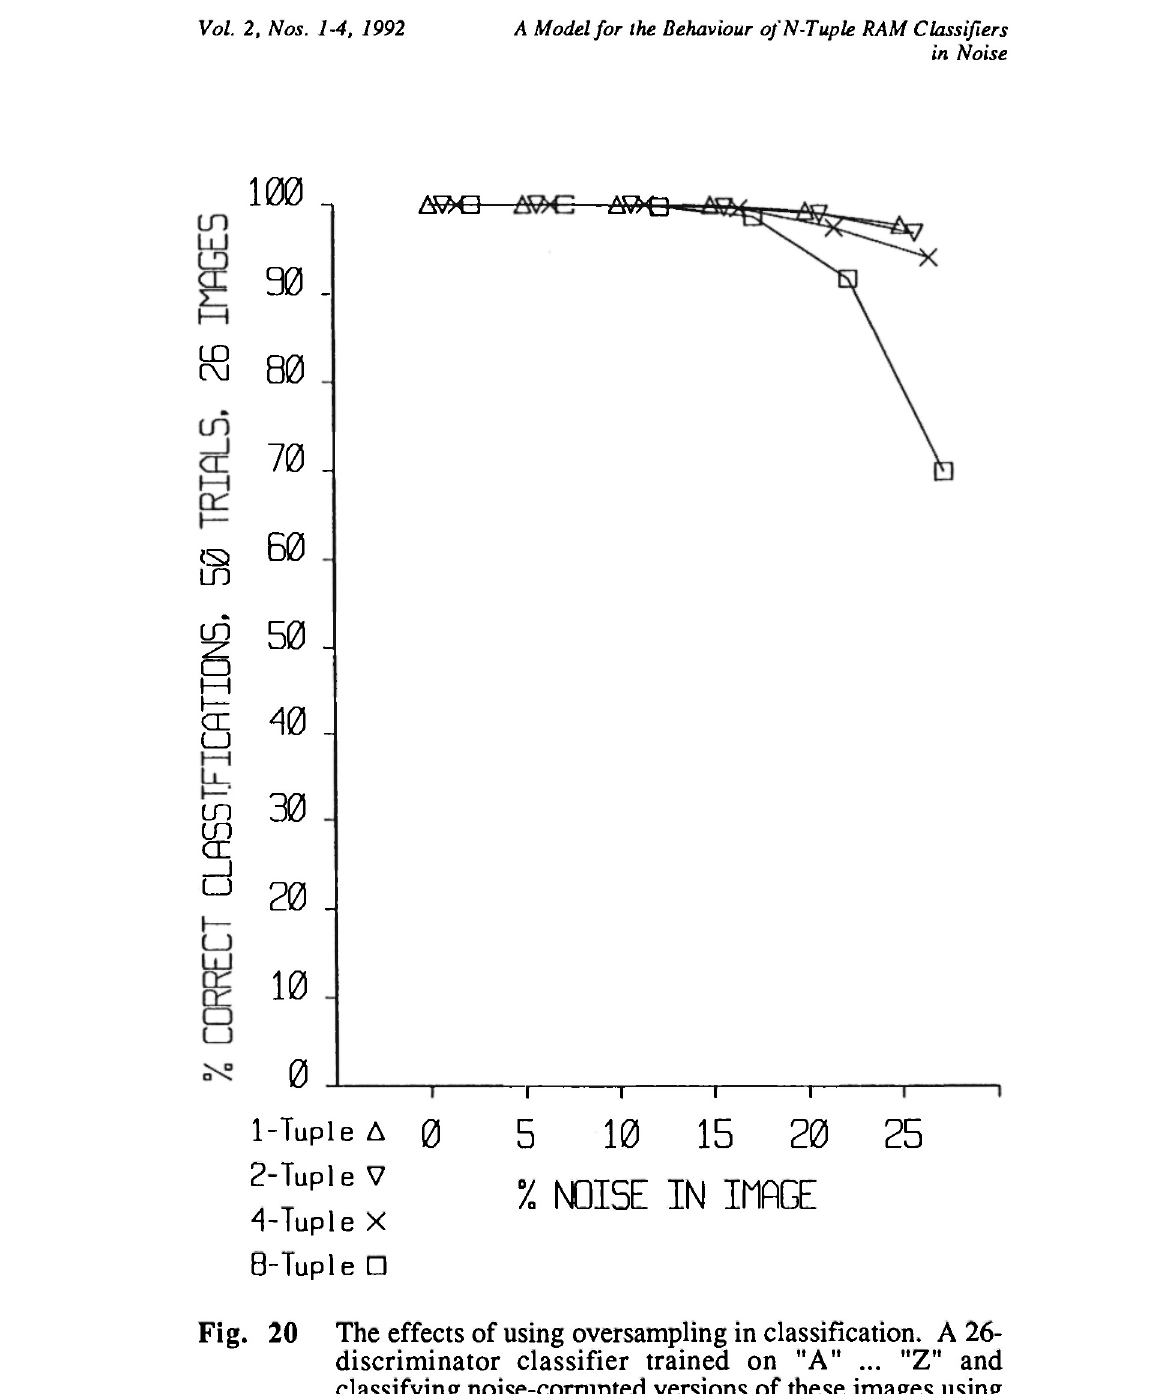
Fig. 20 The effects of using oversampling in classification. A 26- discriminator classifier trained on "A" ... "Z" and classifying noise-corrupted versions of these images using an oversampling factor of 3. 200 trials per